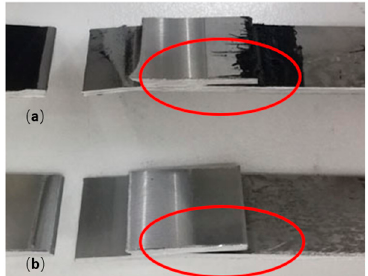
Figure 8. Example of FSWB-FI sample ( a ) and FSWB sample ( b ) failures.